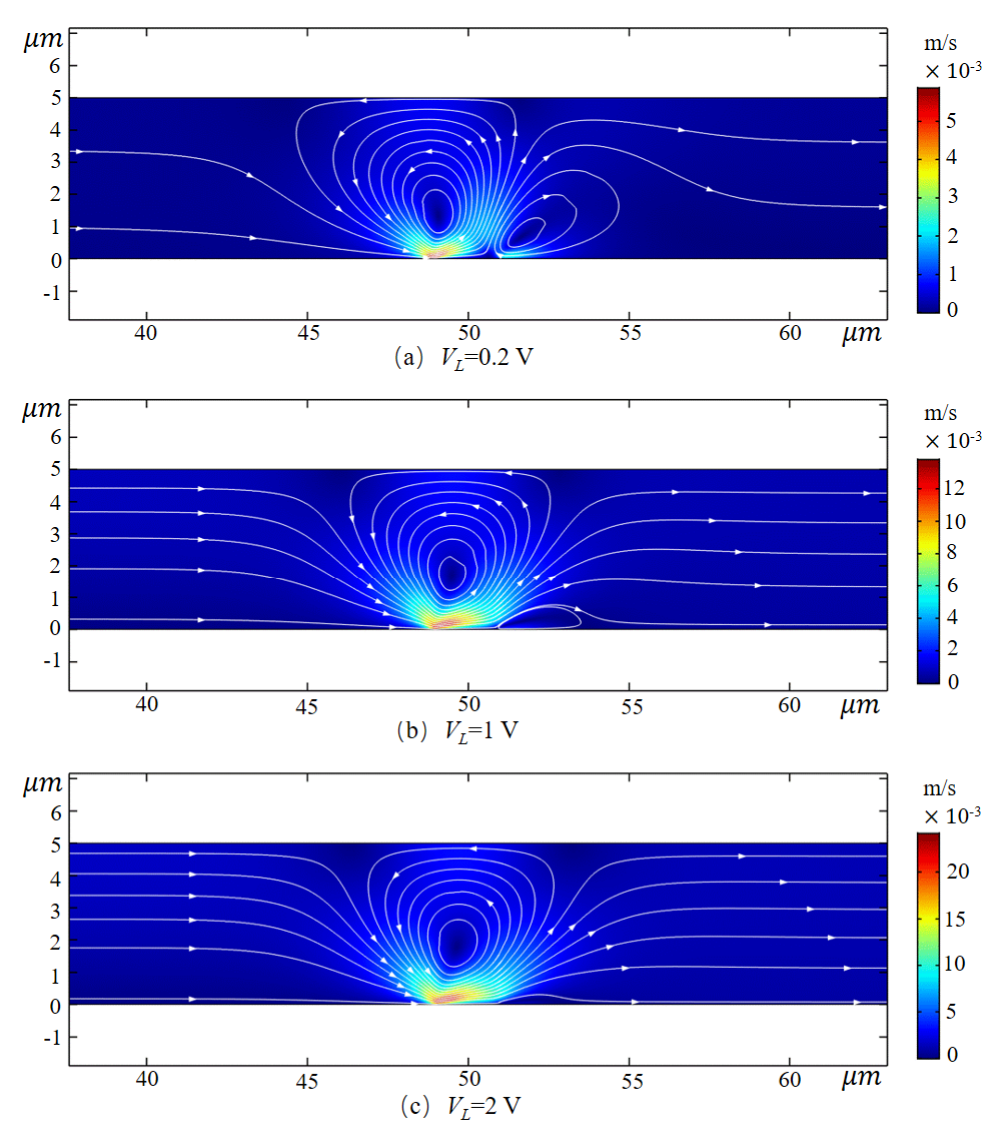
Figure 5. Velocity diagram of the velocity near the endometrial position (49 ≤ x ≤ 51 μm) at different inlet potentials at V cm = 400 mV.